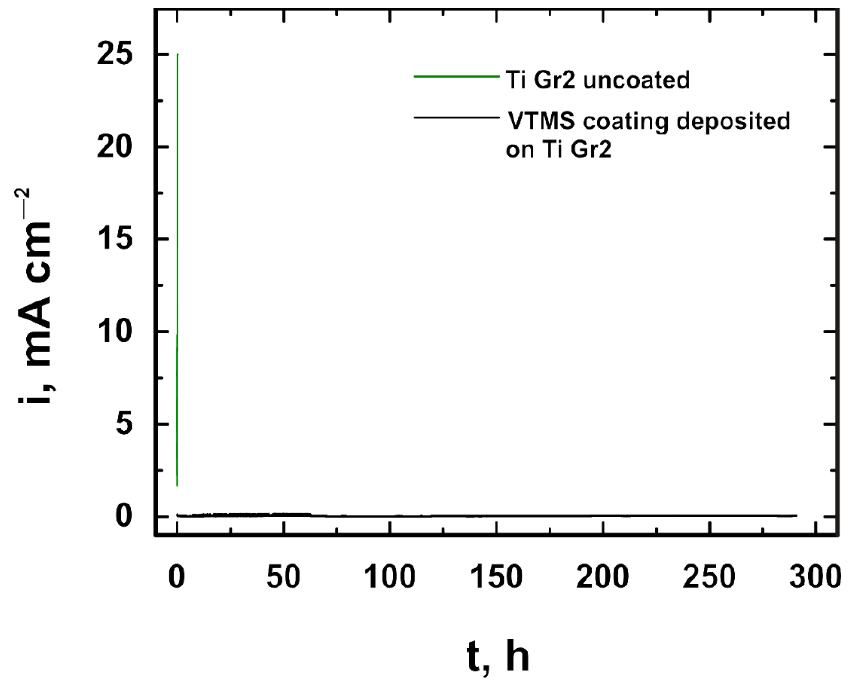
Figure 8. Chronoamperometric curves recorded in a 1 mol dm − 3 NaBr solution at a potential of +1.7 V. Table 2. Chloride ion concentration in individual simulated body